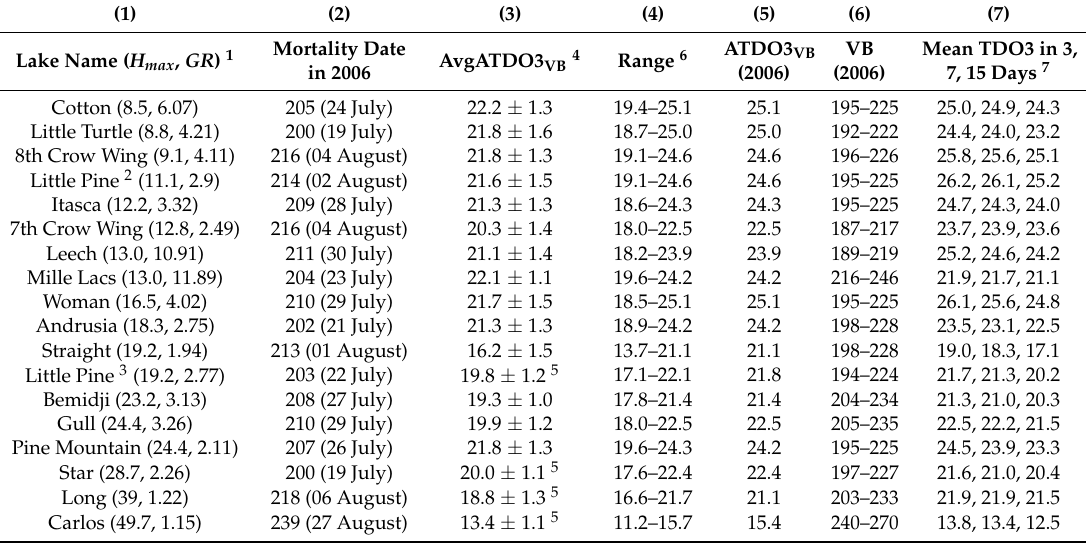
Table 6. Oxythermal stress parameters in 18 cisco lakes in Minnesota for the validation of the refuge lake reclassification